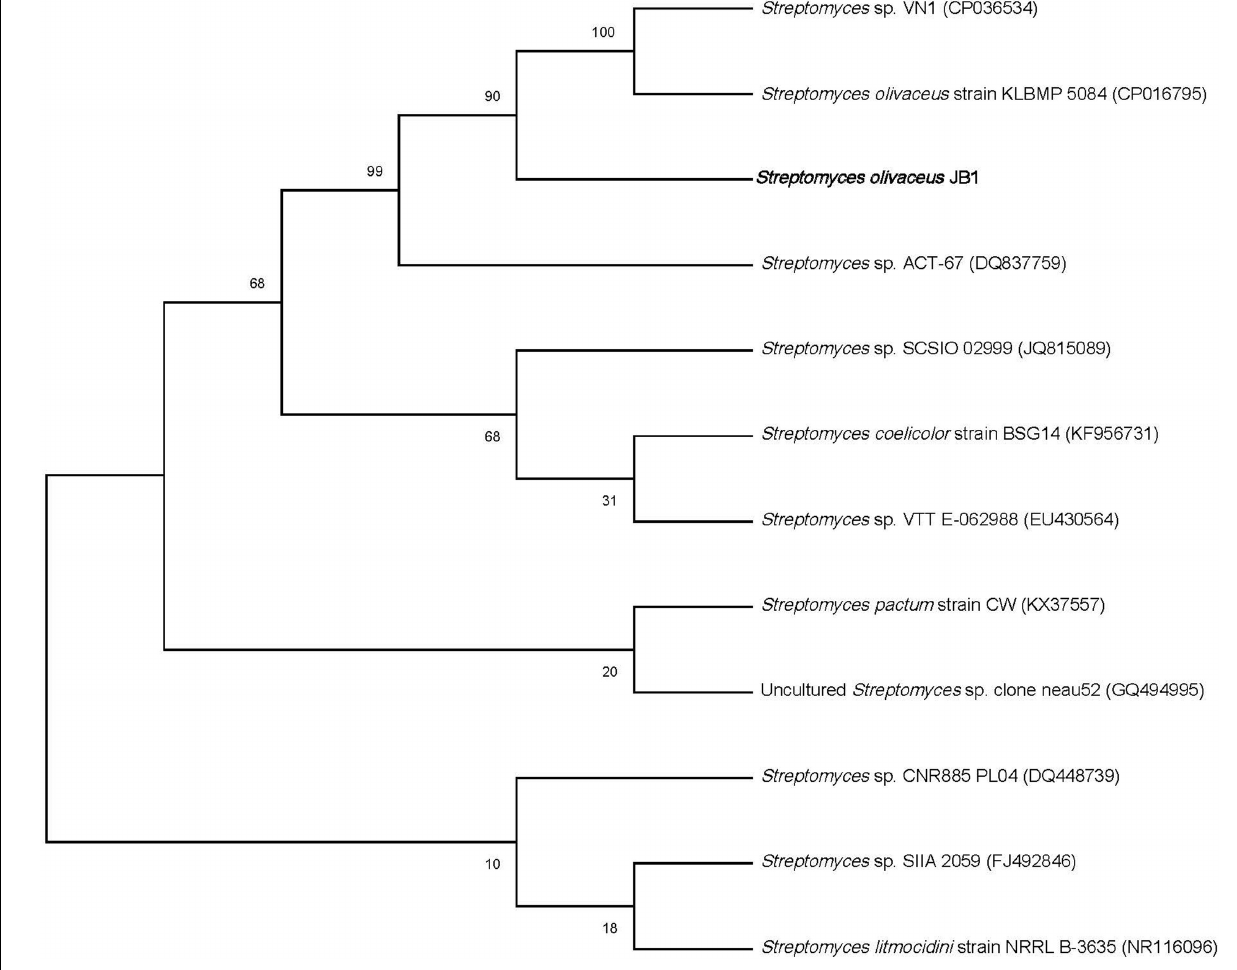
FIGURE 2 | Maximum-likelihood phylogenetic tree showing the phylogenetic relationship of S. olivaceus JB1 and other closely related species based on 16S rRNA gene